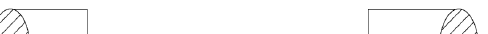
( b ) Figure 4. Effect of the viscosity (steady case): ( a ) streaming potential coupling coefficient; ( b ) effec- tive net residual charge density.